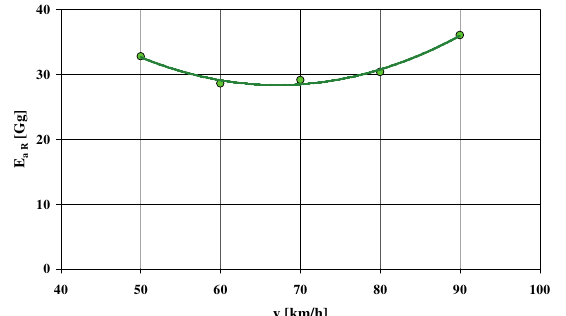
Fig. 12. Dependence of the national annual emission of particulate matter Fig. 8. Dependence of the national annual emission of nitrogen oxides PM10 from tribological elements of passenger cars upon the average from passenger cars upon the average velocity, under model conditions of velocity, under model conditions of traffic on highways and rural traffic